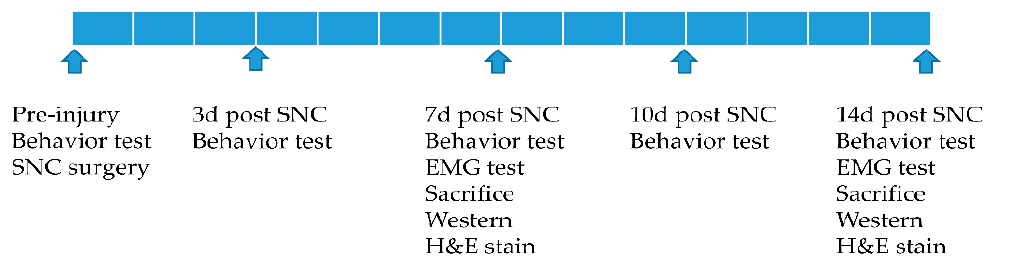
Figure 1. Experimental design and protocol for the drug application.